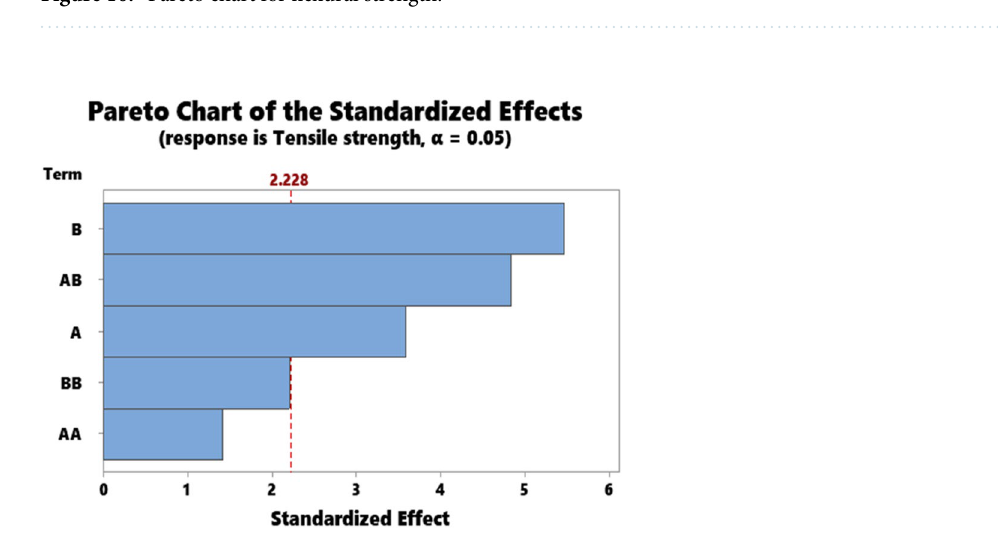
Figure 10. Pareto chart for flexural strength.